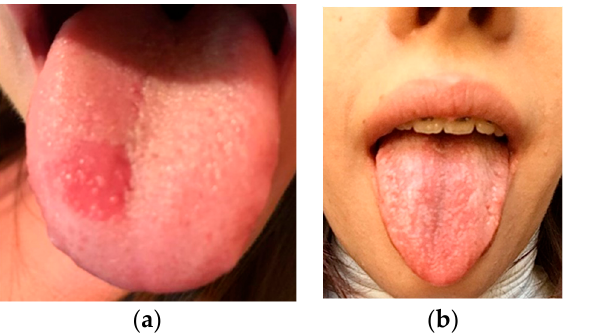
Figure 6. ( a ) Geographic tongue affecting a 16-year-old girl; ( b ) Geographic tongue affecting a 17-year-old girl.